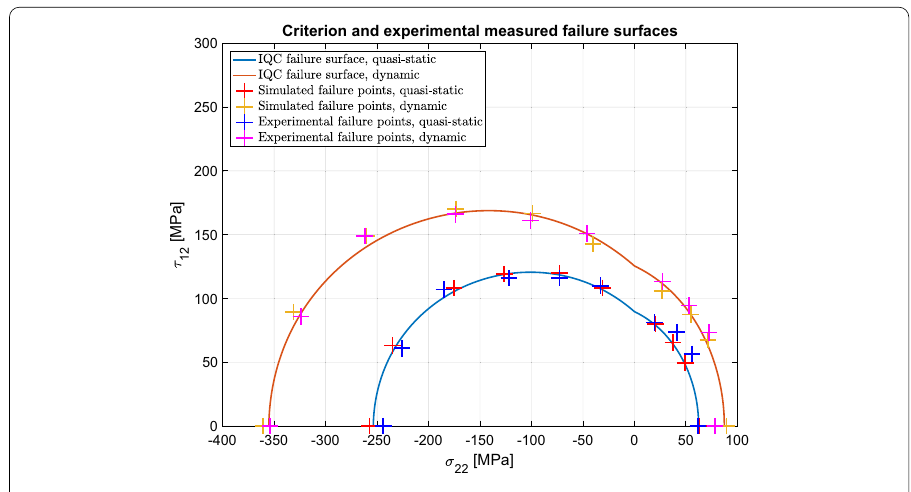
Fig. 6 Failure surfaces and points, experimental and simulated (true stress used for experimental data points)